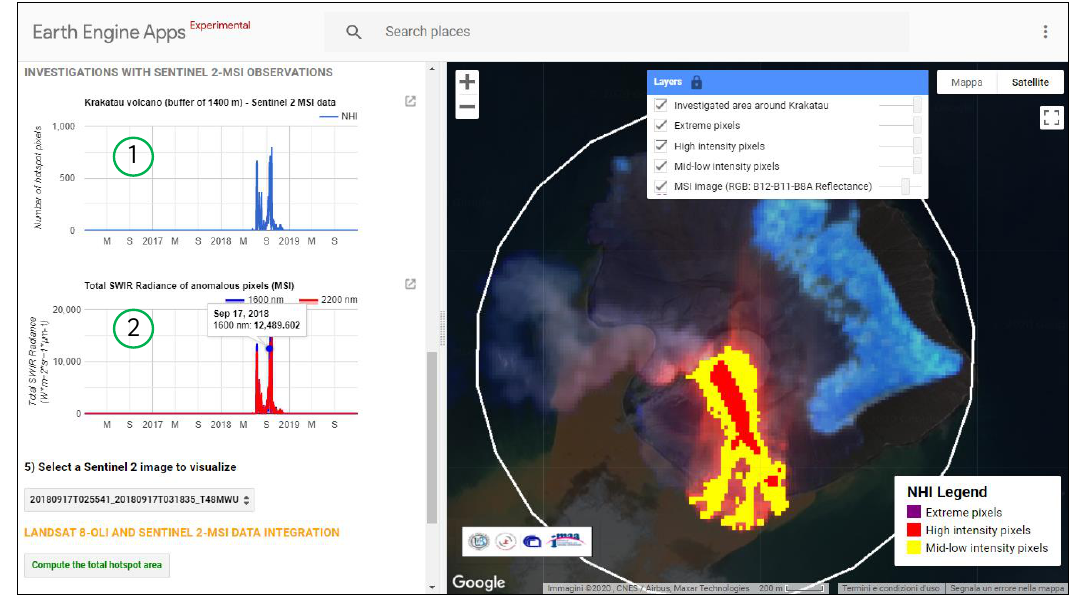
Figure 2. Outputs of the NHI tool: (1) plot of hot spot pixel number versus time; (2) plot of total SWIR radiance. On the right, layers menu and thermal anomaly map (see red/yellow pixels), overlapped to the RGB (Red = Band 12; Green = Band 11; Blue = Band 8A) product from Sentinel-2 MSI data of 17 September 2018, covering the area of the Krakatau ( 6°06′07.2″S 105°25′22.8″E ) volcano (Indonesia).